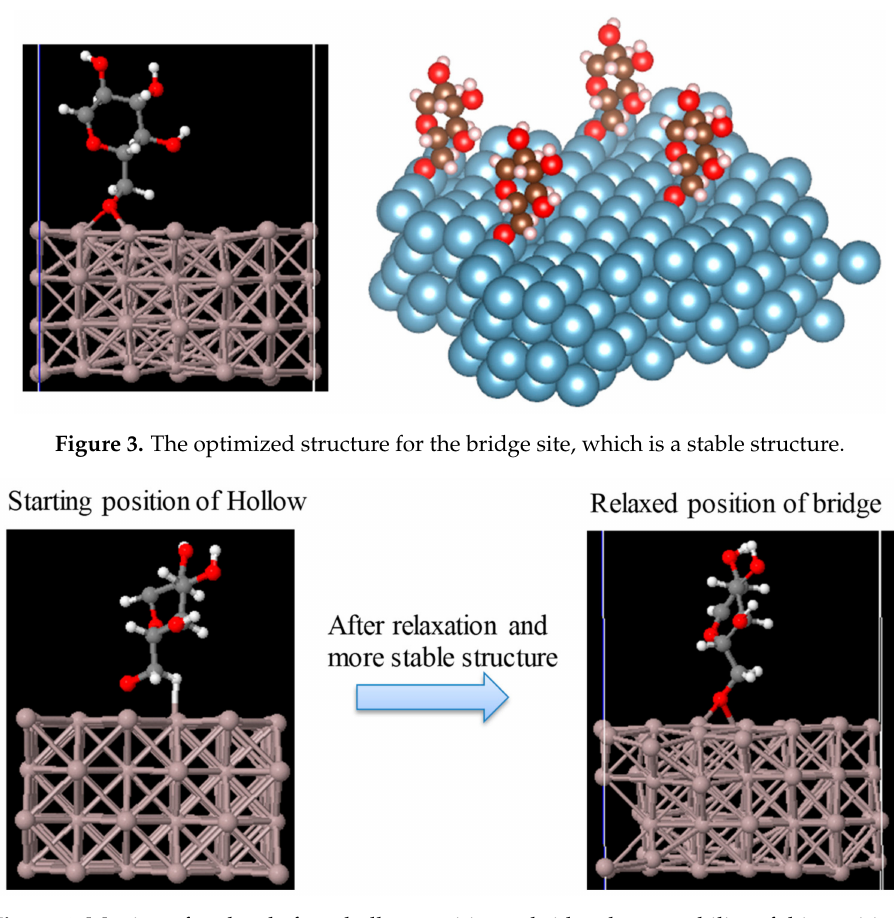
Figure 4. Moving of molecule from hollow position to bridge due to stability of this